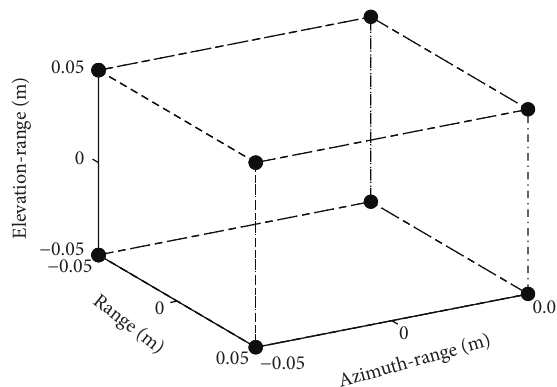
Figure 3: Target model.